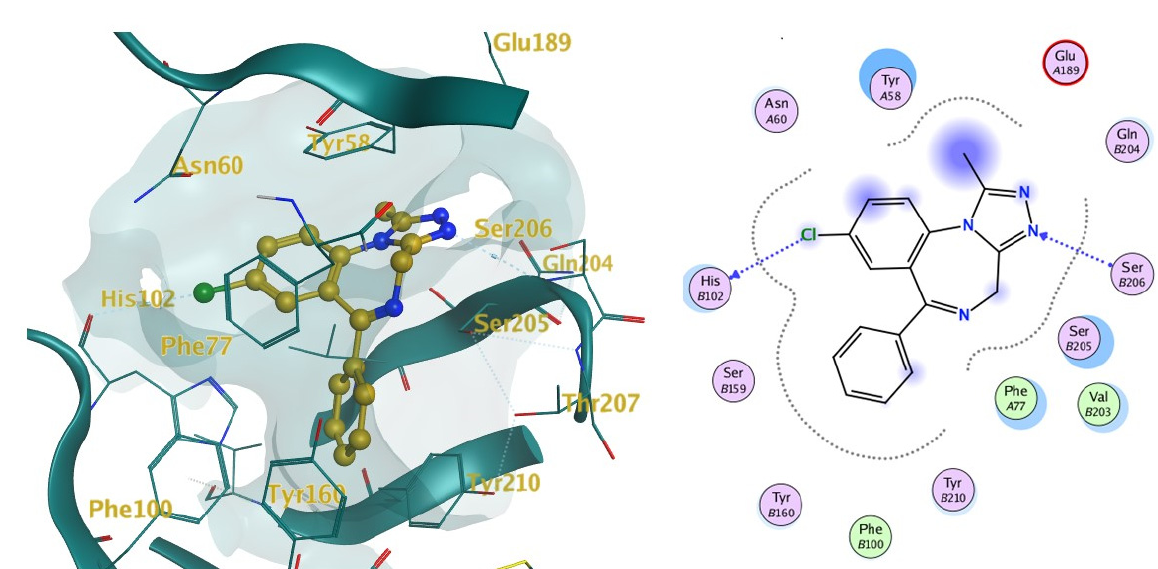
Figure 4. 6HUO [61] binding site 3D and 2D representations. Notes: on the left, the binding pocket 3D representation. The light blue portion represents the receptor backbone whilst the golden one is the complexed ligand alprazolam. The surface of the binding pocket was added (transparent light blue) to define the size of the whole binding site. On the right, the 2D representation of the binding pocket and interactions between receptors residues and ligand is provided. This figure was generated with MOE.